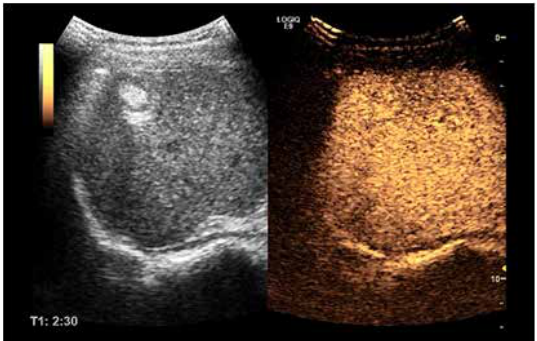
Figure 3 In the portal phase of contrast enhanced ultrasound, the lesion showed slight